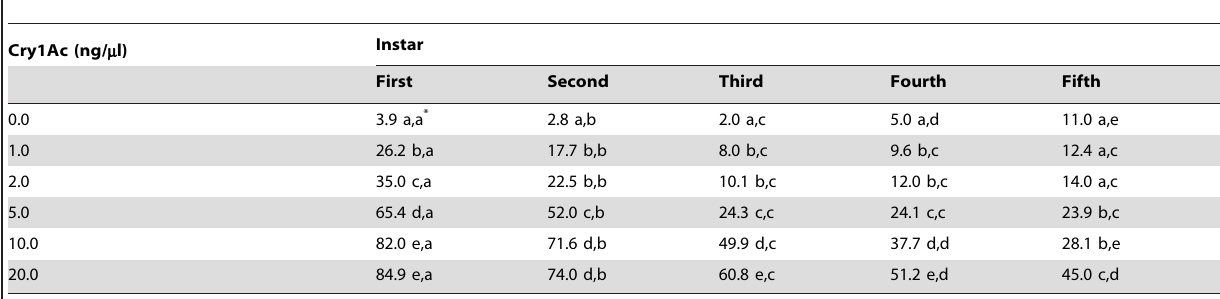
Table 2. Mortality (%) of Chlosyne lacinia (Lepidoptera: Nymphalidae) larvae exposed to Cry1Ac on wild sunflower leaves after immersion for 30 s in a solution containing the indicated concentration of Cry1Ac and 0.02% Tween ( N =10 larvae per instar for each toxin concentration, and were replicated three